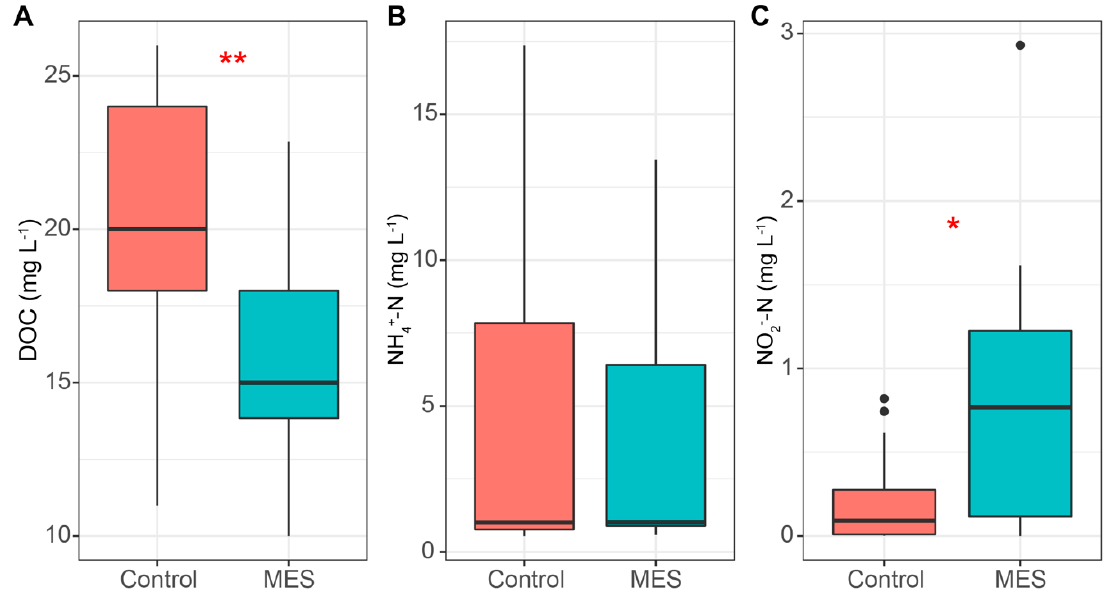
Figure 6. DOC ( A ), NH 4 + ( B ), and NO 2 − ( C ) concentrations in the MES and control reactors. Median, min / max, 25% and 75% quartile values are presented. The asterisks denote statistically significant di ff erences between the MES and control reactors * p < 0.05; ** p < 0.01.